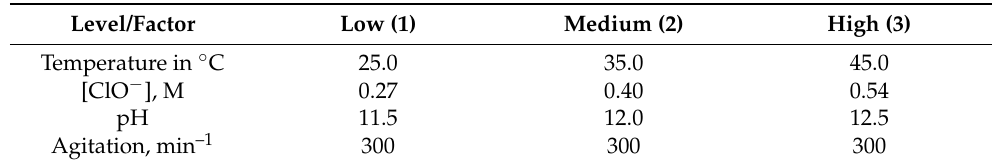
Table 2. Leaching conditions with sodium hypochlorite.